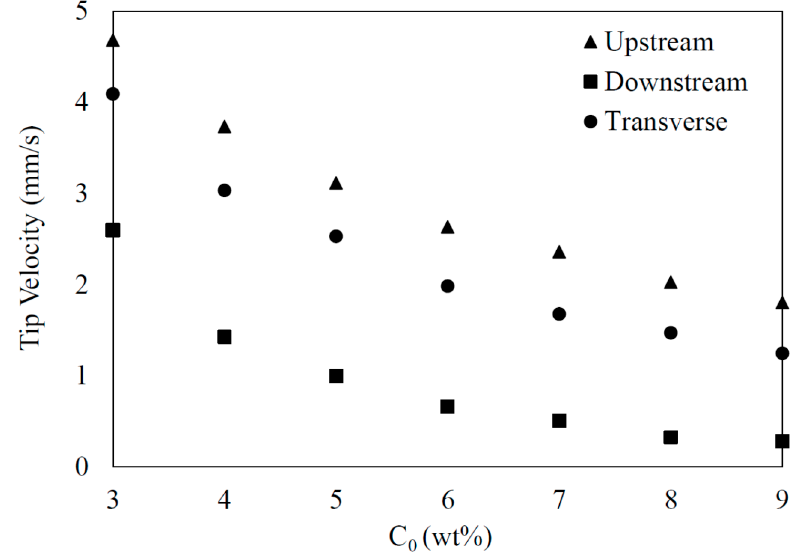
Figure 14. Variation of average tip velocity with initial alloy composition under U 0 = 7 mm/s, and ∆ T = 4.5 °C.